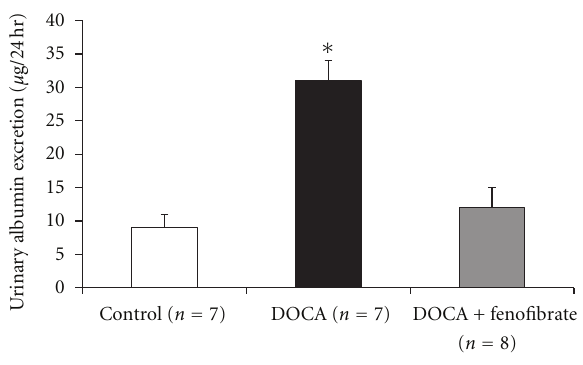
Figure 5: Urinary albumin excretion on day seven in control, DOCA, and DOCA + fenofibrate-treated mice. ∗ indicates DOCA albumin excretion is significantly di ff erent from control and DOCA + fenofibrate-treated mice.